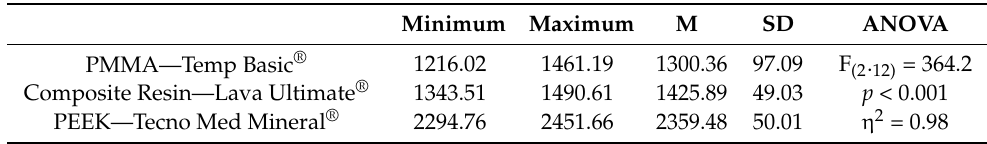
Table 3. Comparison of fracture resistance by material type.